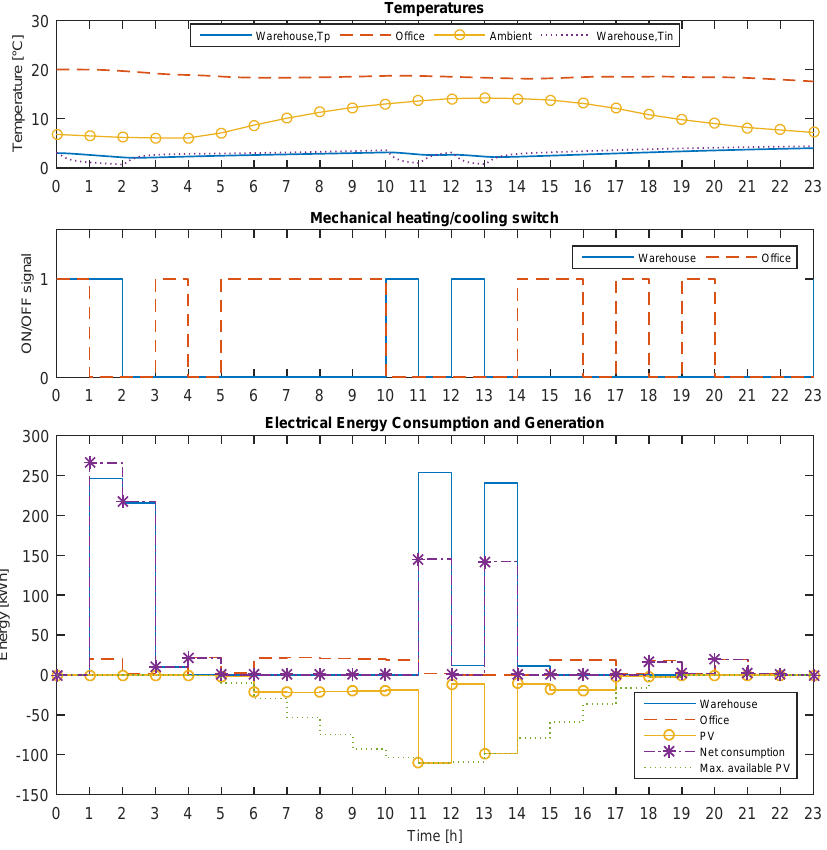
Figure 7. Cost minimization results for the average temperature scenario.